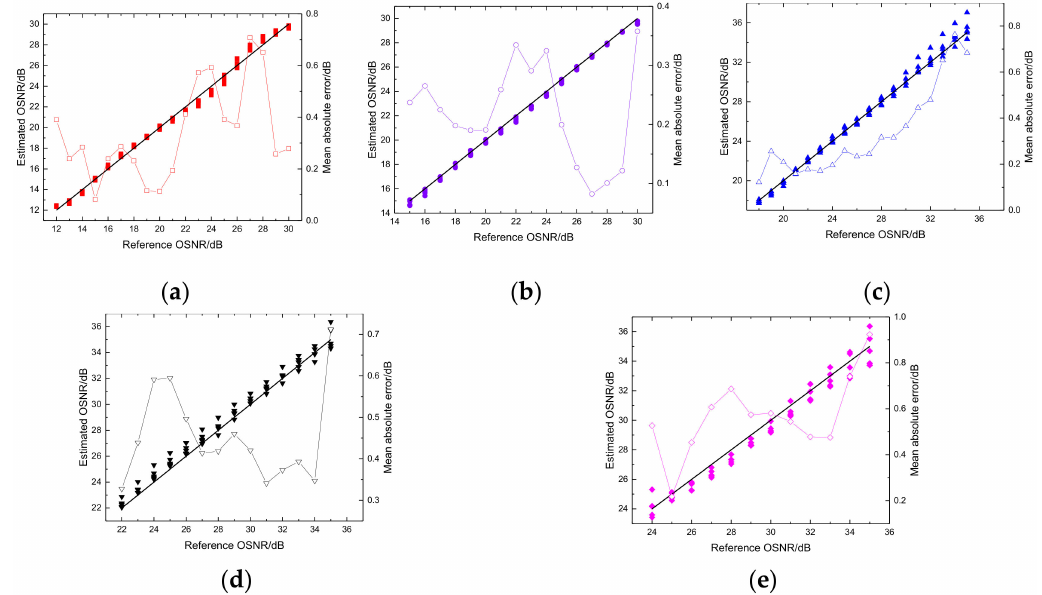
Figure 8. The estimated OSNR and mean absolute error for five MFs. ( a ) QPSK; ( b ) 8PSK; ( c ) 16QAM; ( d ) 32QAM; ( e )